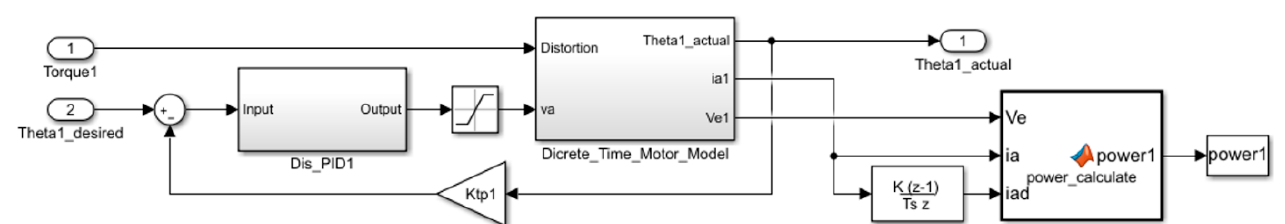
Figure 6. Discrete-time PID controller with power computation block.